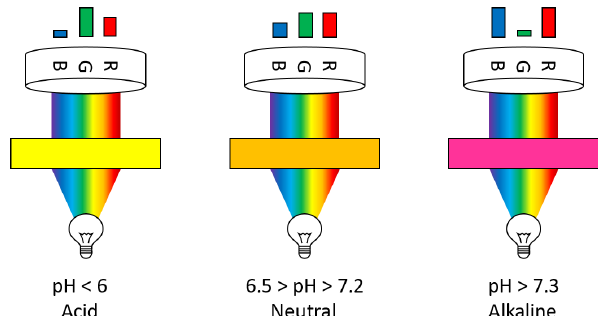
Figure 5. Diagram for the measurement principle of the transmit- ted light prototype with the color changing effect of PhR and the corresponding red, green and blue signals.